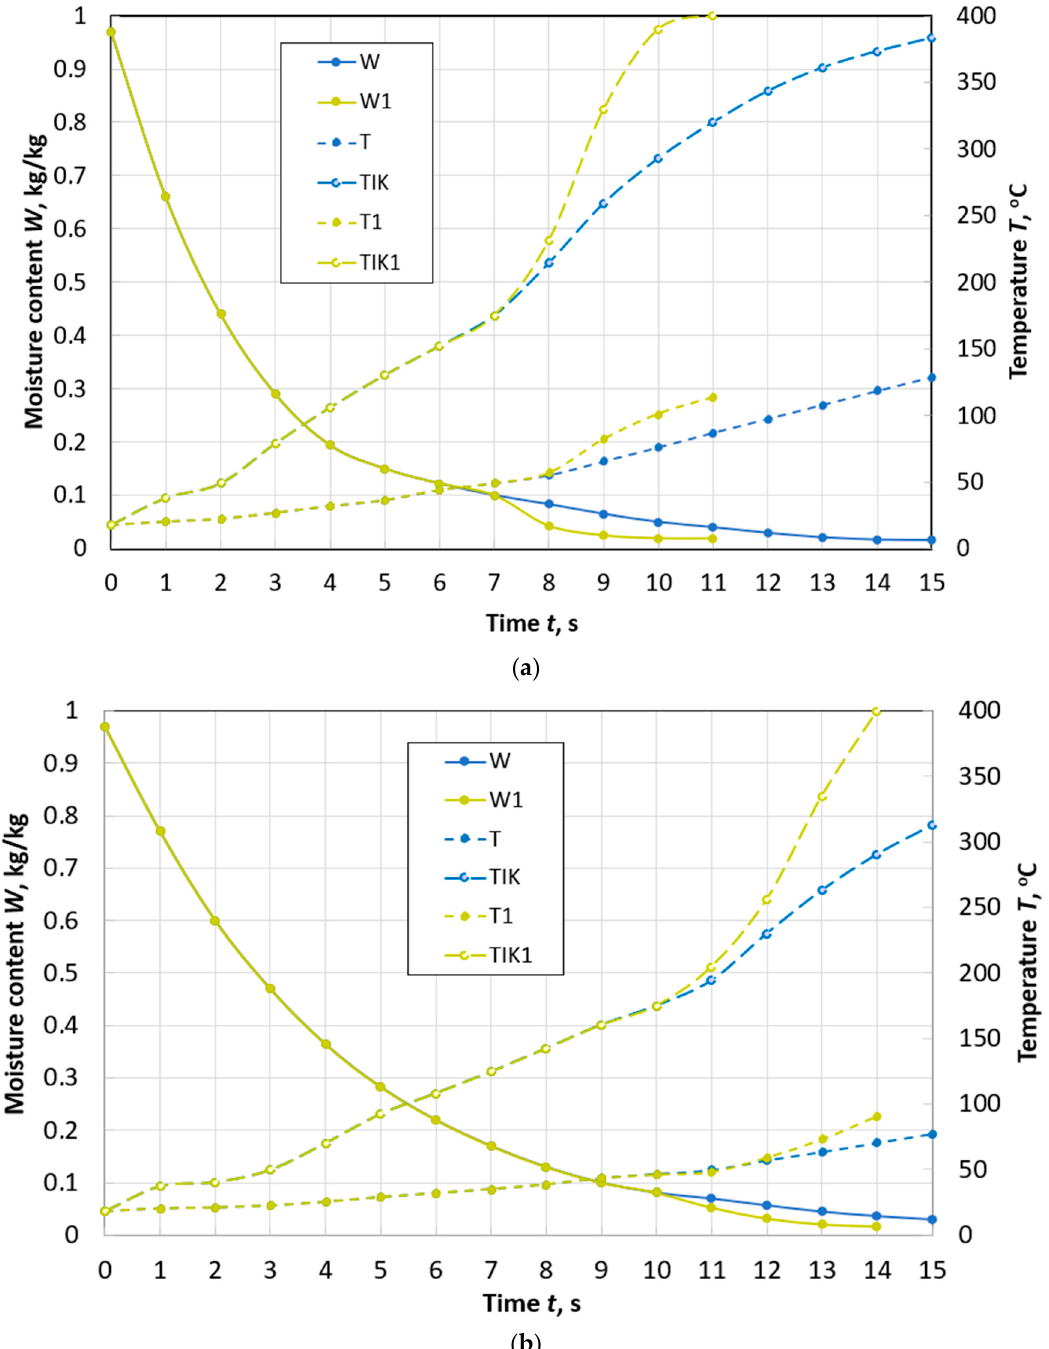
Figure 5. Changes over time in the average values of moisture content W and temperature T , temperature T IK on the surface of a spherical particle of peat with a diameter of d = 10 mm ( a ) and a diameter of d = 13 mm ( b ) during drying with and without taking into account thermal destruction ( W 1, T 1, T IK 1) in the flow of flue gases with parameters: T e.m. = 400 ◦ C, w e.m. = 4 m/s, d e.m. = 12 g/kg of dry gas.